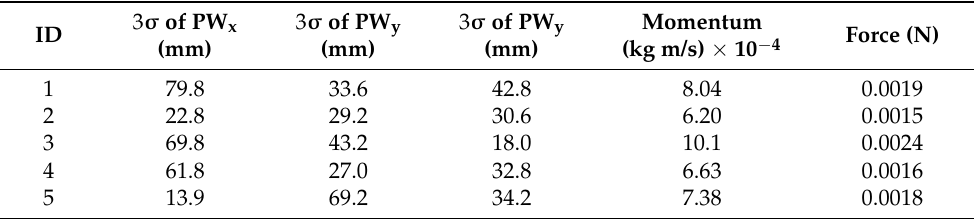
Table 3. The uncertainty data of five fragments using bundle adjustment with frame-rate magni- tude